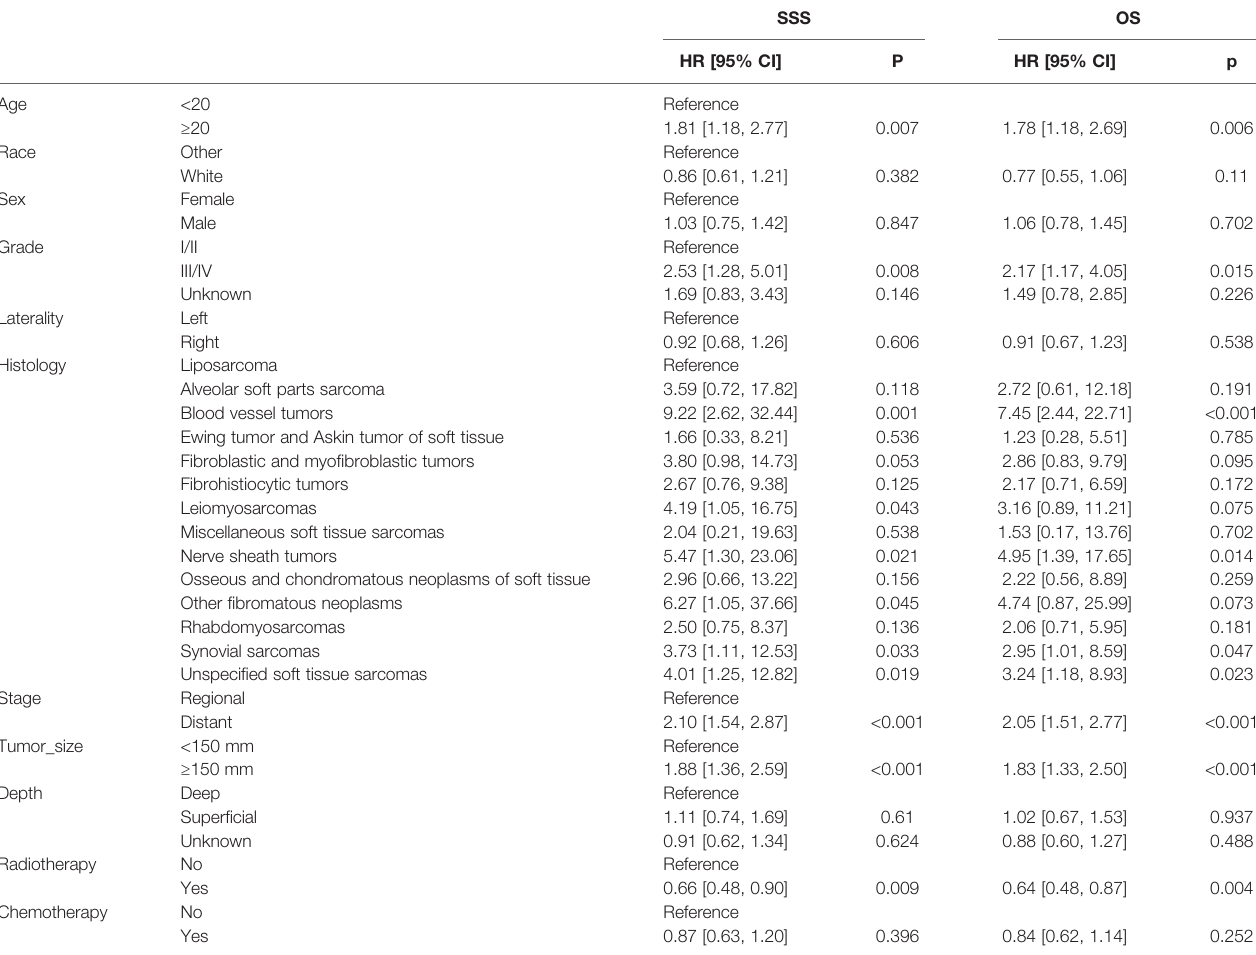
TABLE 3 | Univariable Cox regression models for sarcoma-speci fi c survival and overall survival in patients with STSE-RLNM in the unadjusted